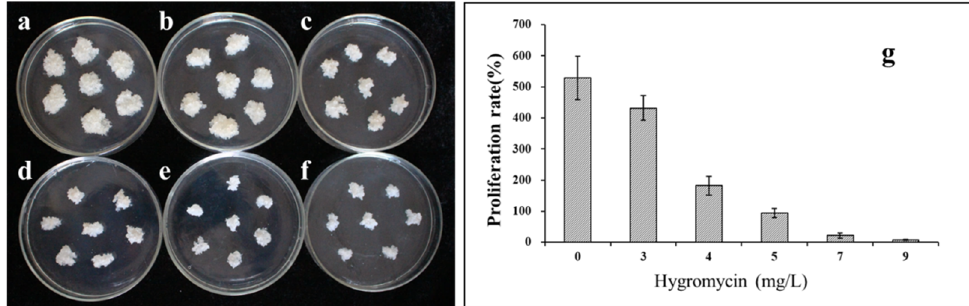
Figure 2. Proliferation frequency of non-transformed embryogenic tissue from hybrid larch line S287 on medium supplemented with various hygromycin concentrations. ( a ) 0, ( b ) 3, ( c ) 4, ( d ) 5, ( e ) 7, and ( f ) 9 mg/L of hygromycin. When the antibiotic concentration was raised to 5 mg/L, it was sufficient to prevent cell proliferation. ( g ) The proliferation rate of embryogenic cultures after 20 days of culturing on medium containing various hygromycin concentrations.